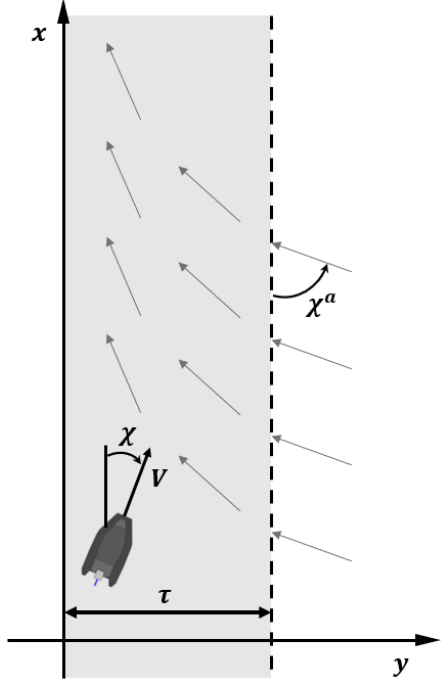
Figure 5. Schematic of the vector field concept for a linear